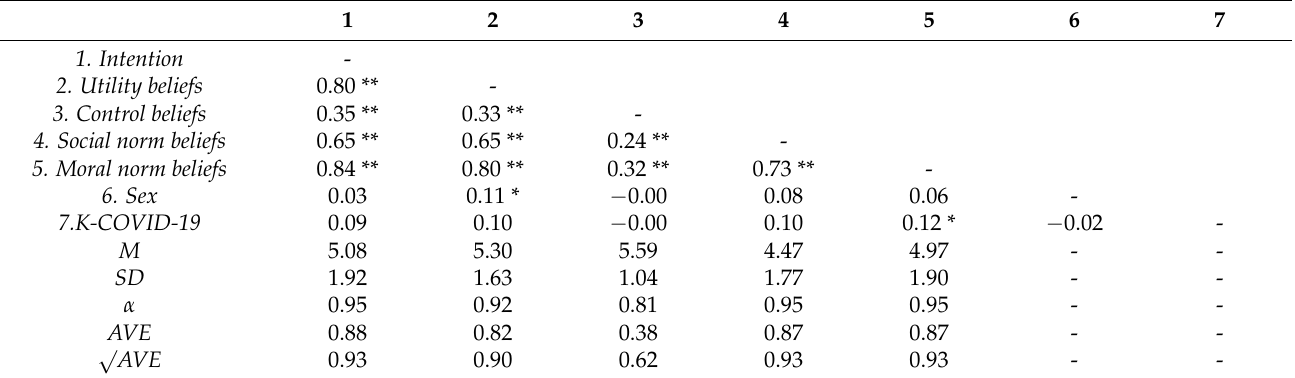
Table 6. Spearman’s rho, means, standard deviations, and average variance extracted in Study 2.